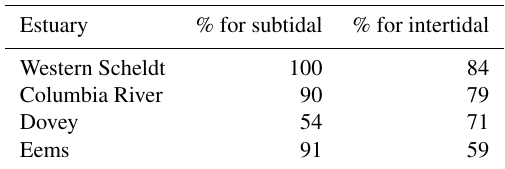
Table 2. Percentage of points predicted within a factor of 2 from the measured